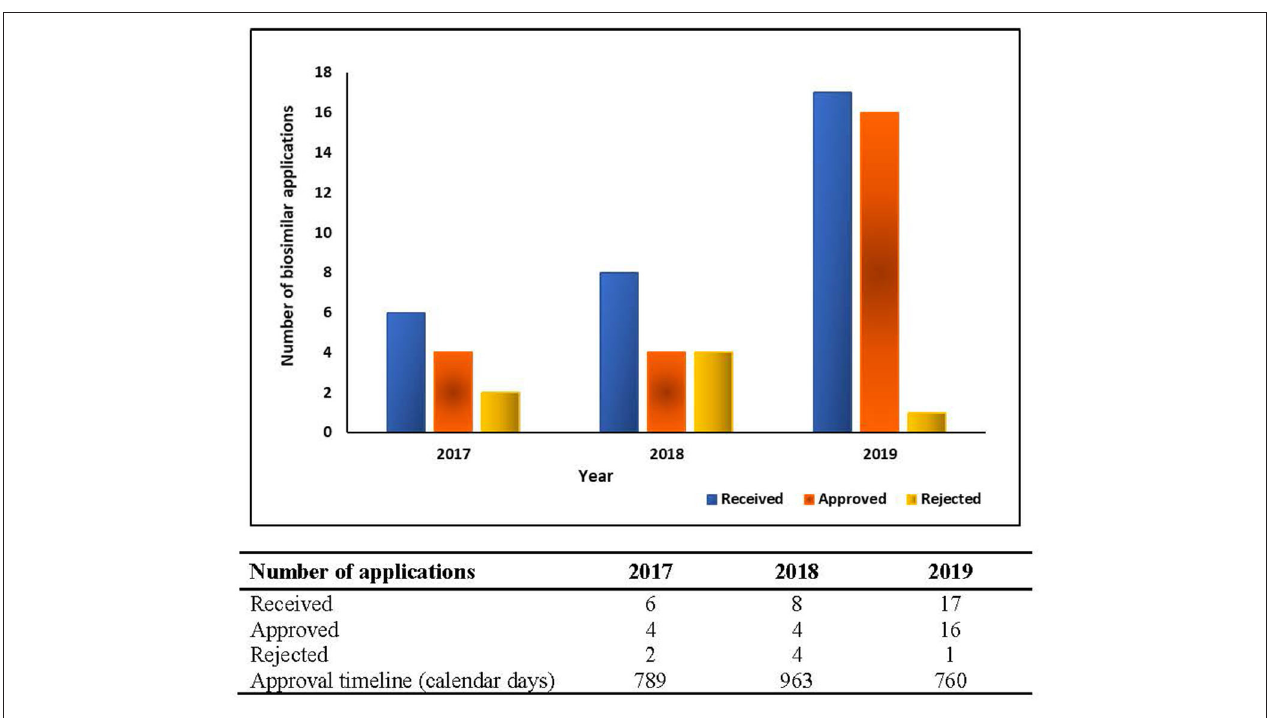
FIGURE 2 | Biosimilar approval metrics of ANVISA –